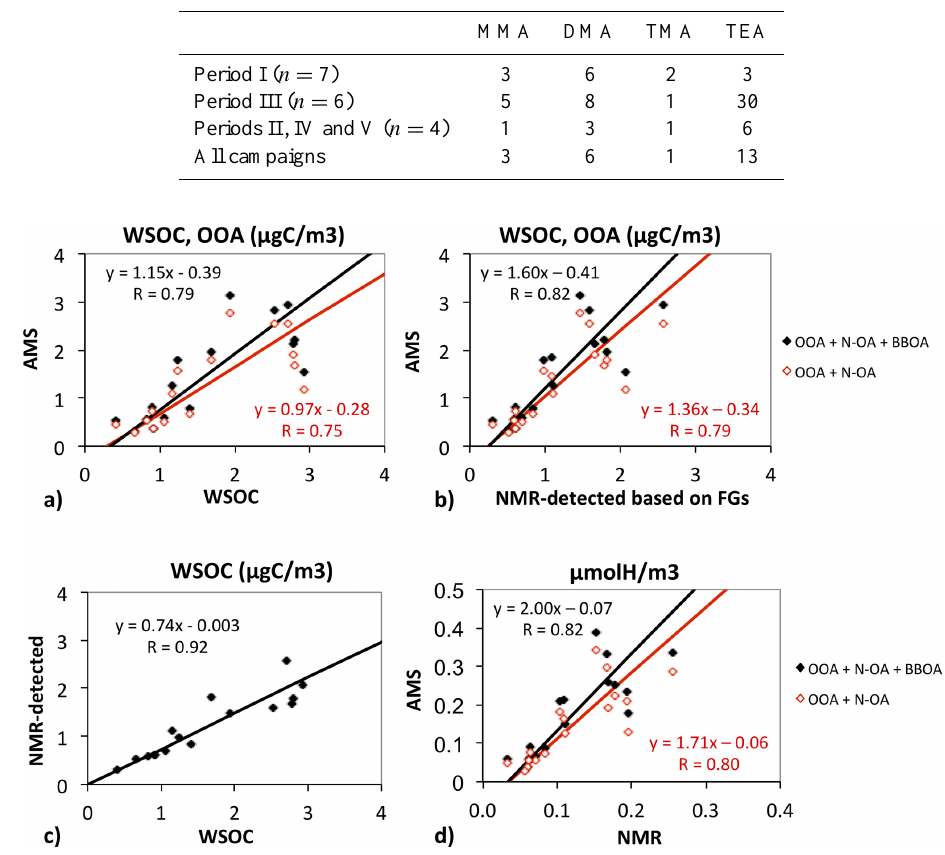
Figure 1. (a) , (b) , (c) Orthogonal fitting between carbon classes derived from TOC analysis, AMS measurements and 1 H-NMR analysis. (d) Scatter plot (with orthogonal linear fit again) between AMS and 1 H-NMR concentrations of organic hydrogen.